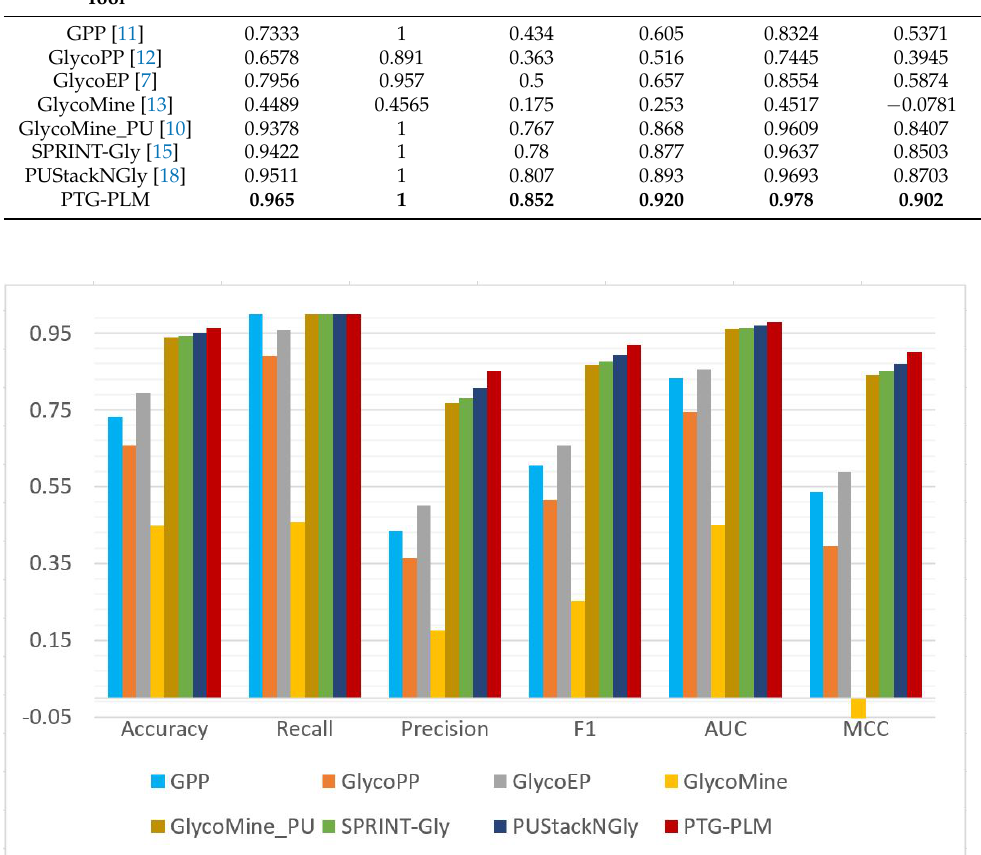
Figure 7. Chart for the performance of PTG-PLM and the existing tools for Ngly site